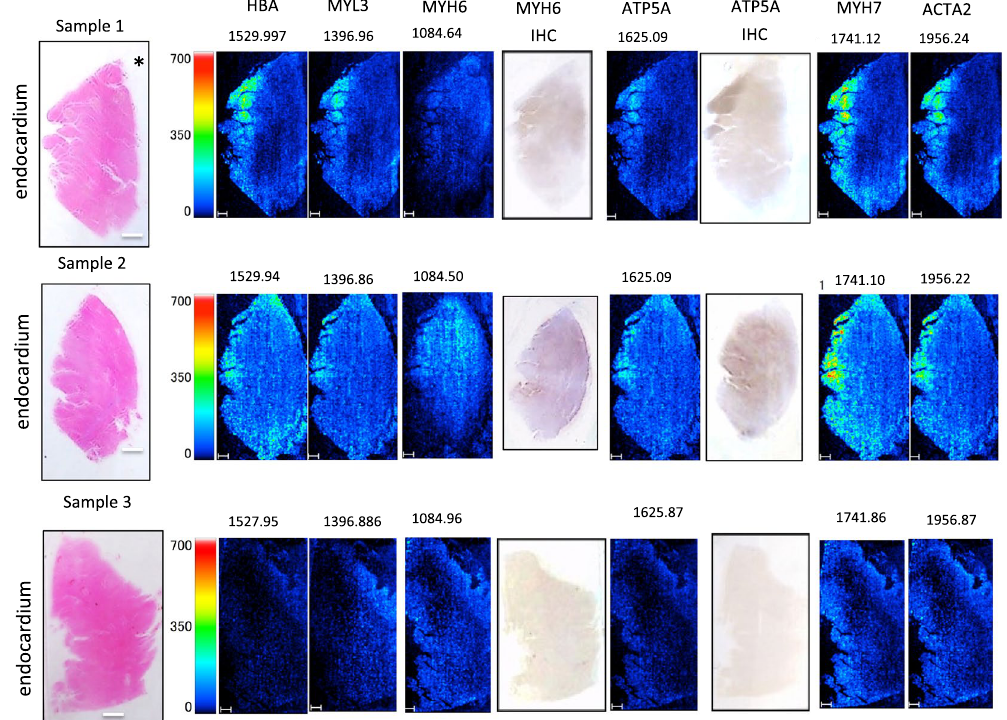
Figure 3. MALDI-IMS analyses. HBA, ATP5A, MYH6, MYH7, MYL3, and ACTA2 IMS signal analyses (for samples 1, 2, and 3) were obtained using MALDI-TOF-MS. The ions were identified using the same tissue samples as in the MS/MS experiments. Scale bars, 500 μ m. H&E staining images and orientation (endocardium and pericardium) along with ROI are indicated in the left column. The identified proteins are indicated at the top; m/z values are shown above the images. IHC represents immunohistochemistry of individual proteins. Asterisks “ * ” represent the coronary artery.